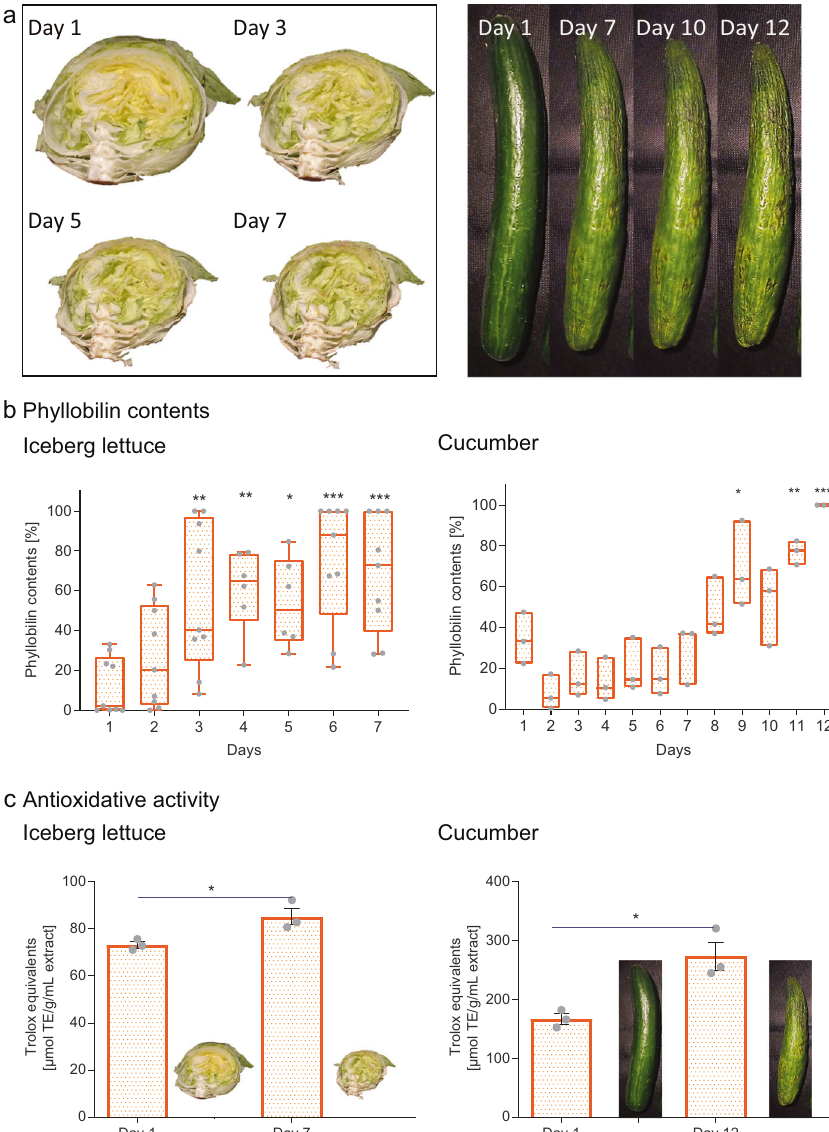
Fig. 1 Analyses of stored greens. a Snapshots of a time-lapse study (videos available as Supplementary Material) showing the aging progress of iceberg lettuce and cucumbers during home storage. b Phyllobilin contents in lettuce and cucumbers signi fi cantly increased with storage time (box-and-whiskers plot (lettuce): box 25 – 75%, whiskers min – max, line at median; fl oating bars (cucumber): min – max, line at mean value; * p < 0.05, ** p < 0.01, *** p < 0.001). c End-of-storage extracts of the lettuce and cucumbers have signi fi cantly higher antioxidative in vitro activity compared to freshly bought produce. Values expressed relative to the antioxidant Trolox (* p < 0.05). Mean values ± s.e.m are